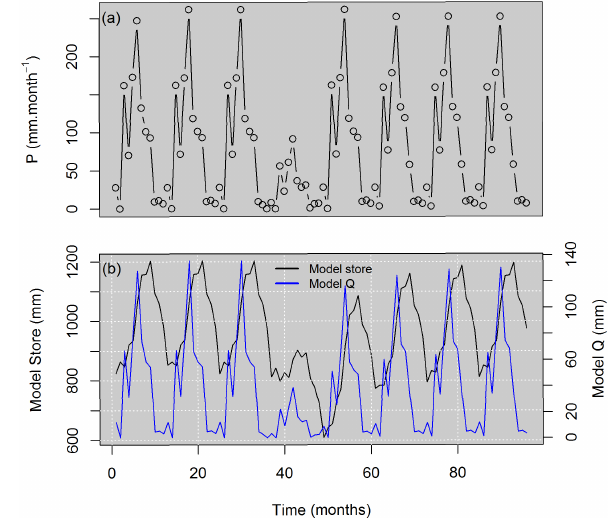
Figure 4. Precipitation input, simulated runoff and model store for the S1S model. Parameters p 1 and p 2 are set to 1 for the simulation results presented in this figure.